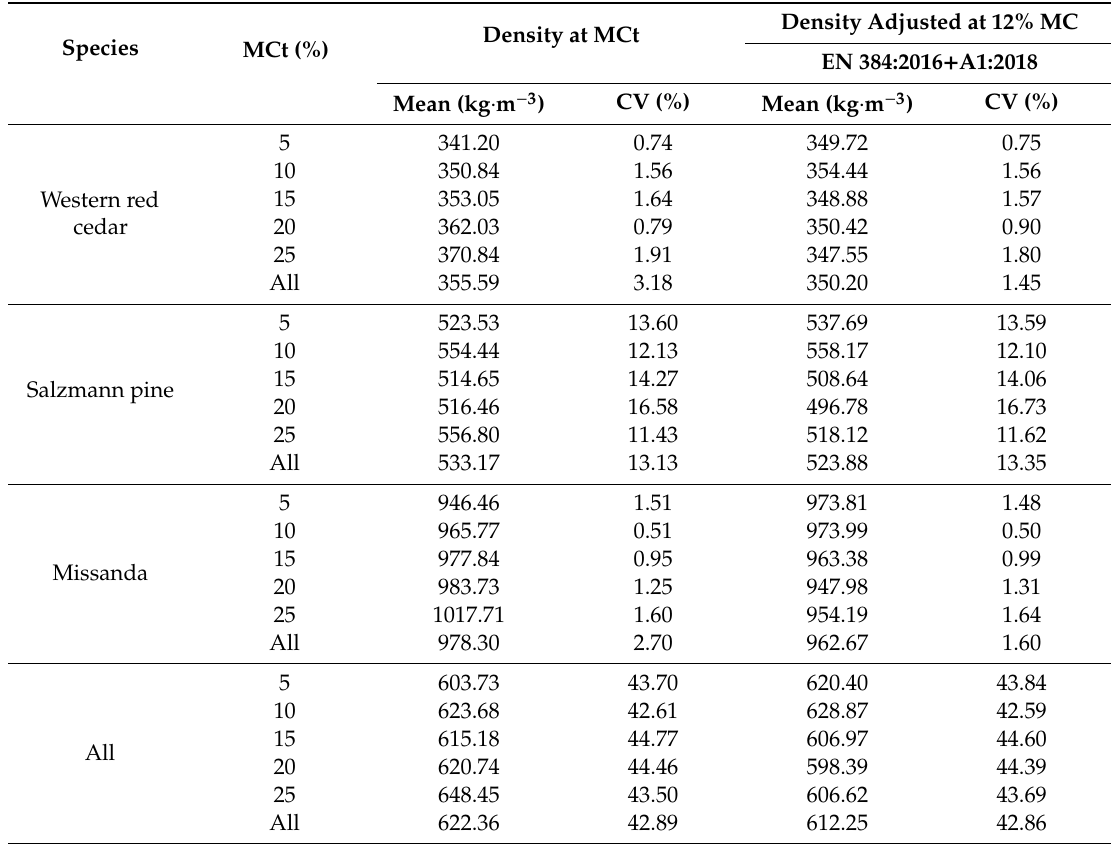
Table 7. Average of the densities of the specimens for the di ff erent MCt and adjusted at 12% MC. Density Adjusted at 12% Density at MCt Species MCt (%)